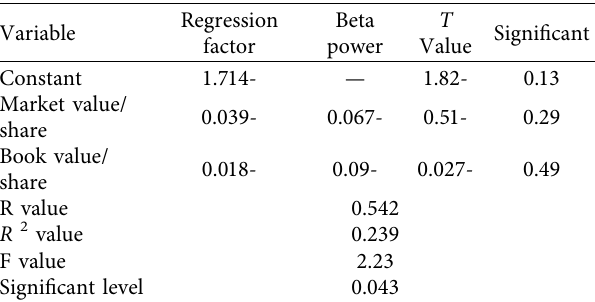
Table 11: Results of multiple linear regression analysis of the efect of analyzing fnancial statements on the ratio of market value to book value.